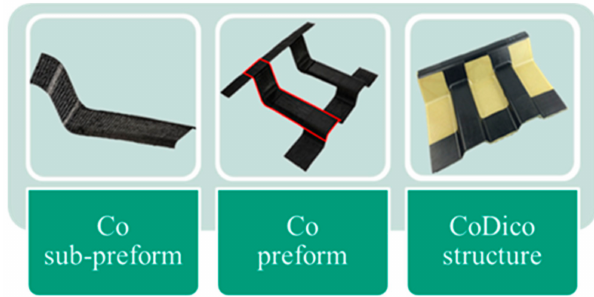
Figure 1. Example of a local continuous fiber reinforced composites (CoFRP, black) reinforced discontinuous fiber reinforced composites (DiCoFRP, white) structure (obtained from